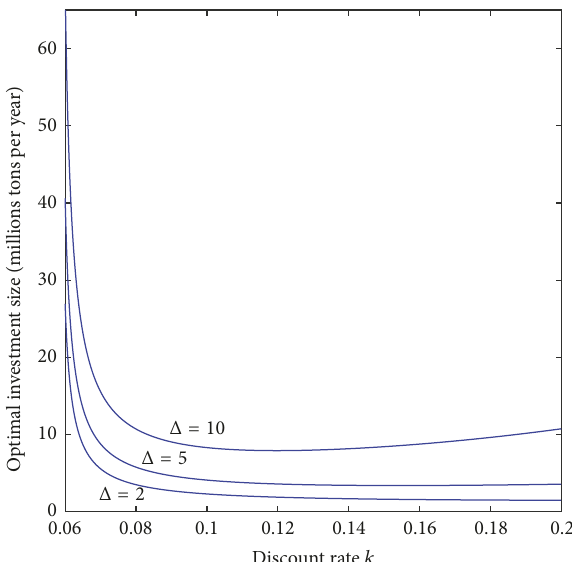
Figure 5: Change of the optimal size with the discount rate and project construction duration.